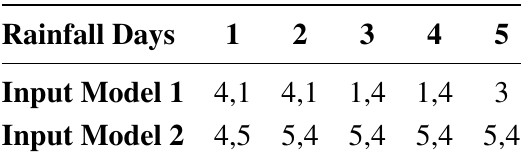
Table 3. Strips of the catchment generally (not always) producing the highest correlation coefficients in predicting freshwater levels at the Lee Maltings site where 2 days antecedent water level information is input to the NN